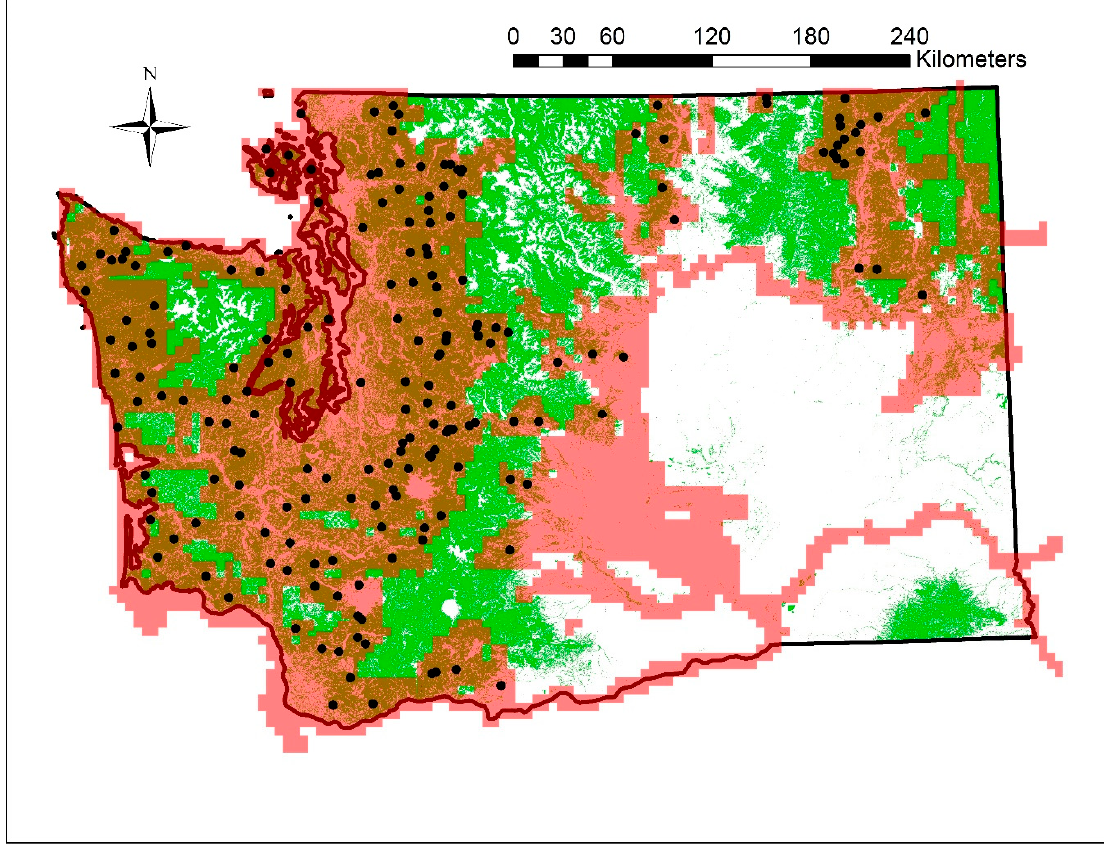
Figure 3. The extent of public domain lidar-derived bare earth DTMs (transparent red) is plotted over forested areas (green). Fuzzed FIA plot locations are shown as black dots. The number of plots in NE Washington is small because some of the DAP DSM (extent not shown) was not completed at the time of this analysis.